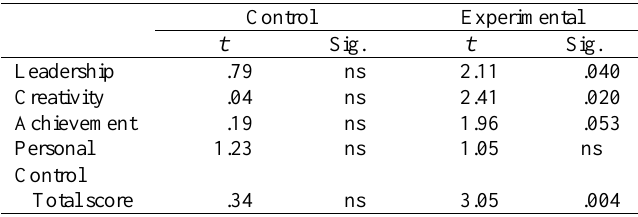
Table 4: ATE test factors: Paired-comparison t-test Control Experimental